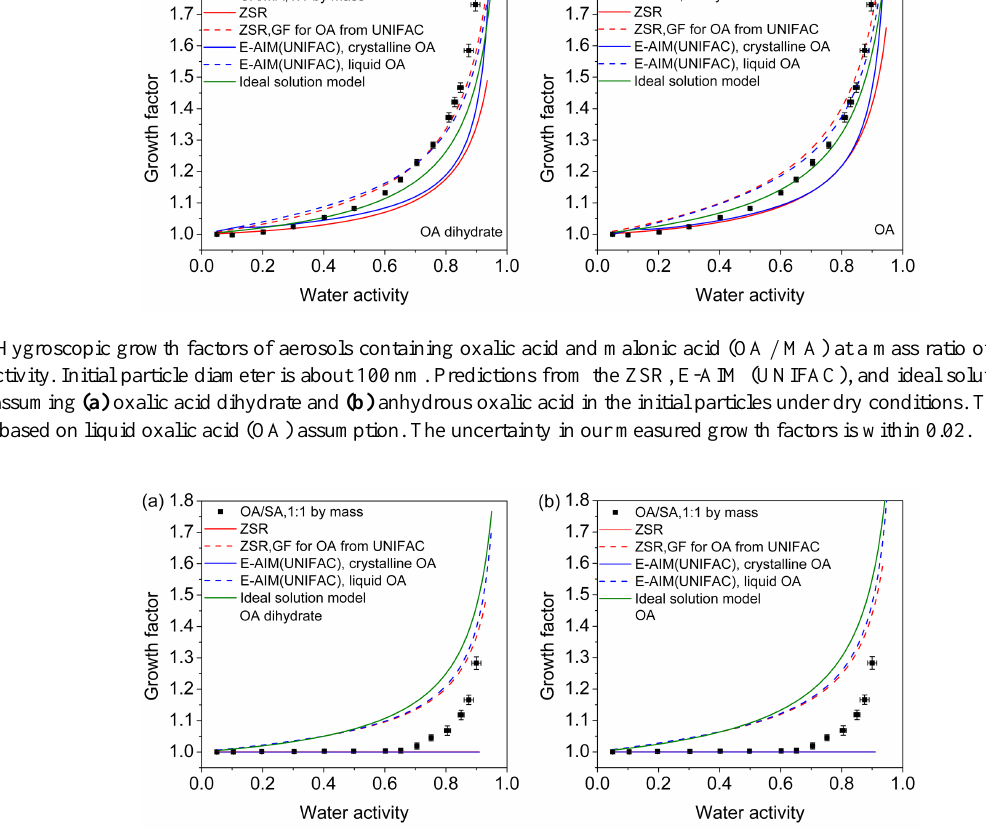
Figure 7. Hygroscopic growth factors of aerosols consisting of oxalic acid and succinic acid (OA / SA) at a mass ratio of 1:1 as a function of water activity. Initial particle diameter is about 100nm. Predictions from the ZSR, E-AIM (UNIFAC), and ideal solution model are also included, assuming (a) oxalic acid dihydrate and (b) anhydrous oxalic acid in the initial particles under dry conditions. The dashed lines are calculated based on liquid oxalic acid (OA) assumption. The uncertainty in our measured growth factors is within